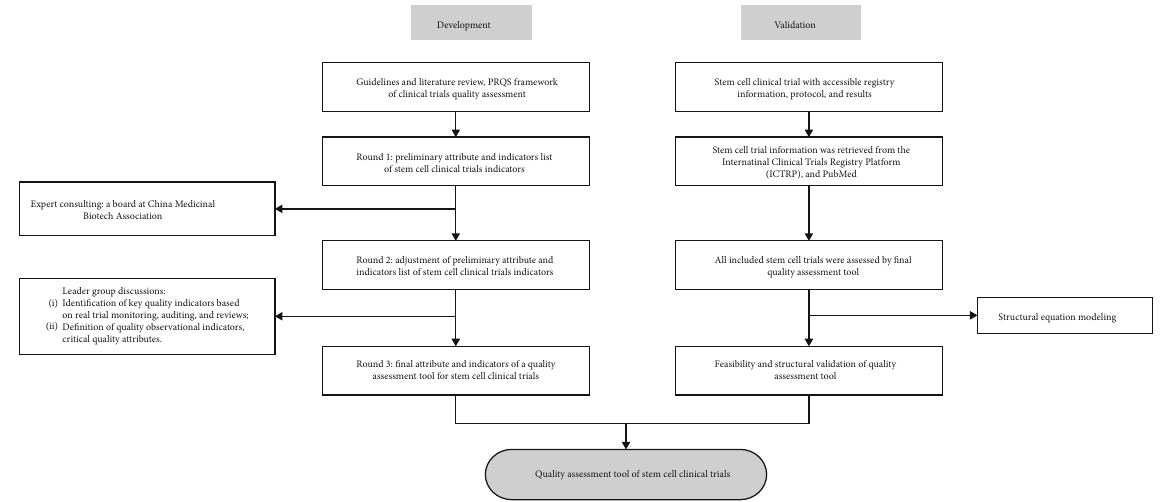
Figure 1: Flowchart of development and validation of quality assessment tool for stem cell clinical